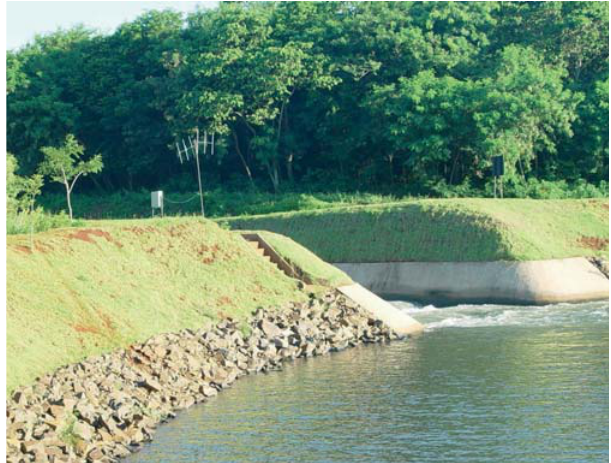
Fig. 3. Radio-telemetry fixed station at “Lago das Grevilhas”, in the lateral channel near Itaipu